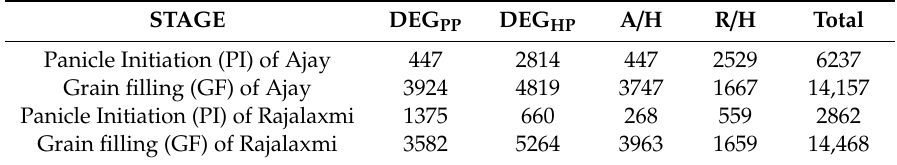
Table 3. Number and classification of DEGs of panicle initiation and grain filling